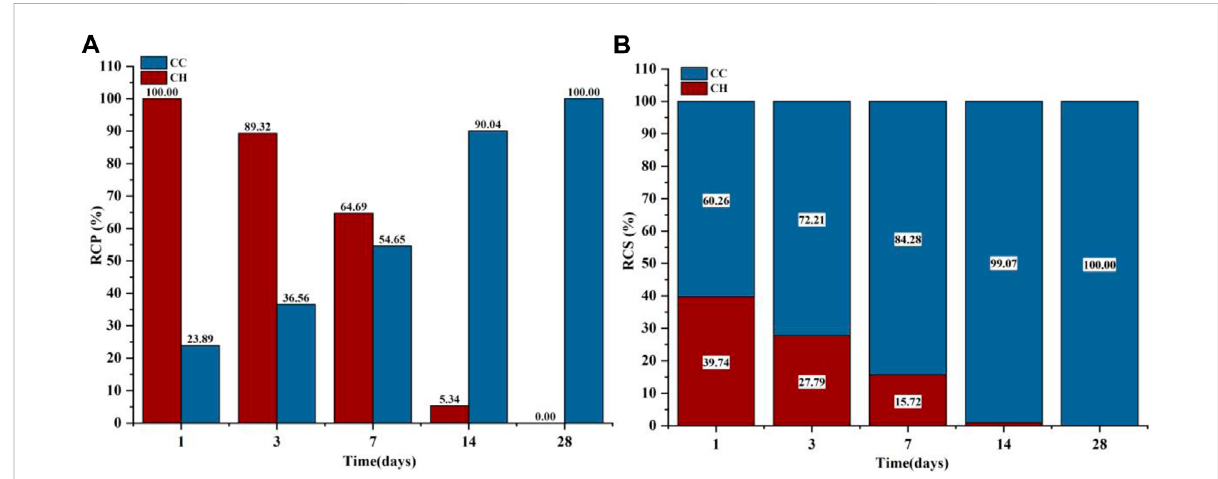
FIGURE 6 GA-1,3,7,14,28 Samples: (A) Carbonized crystalline product RCP; (B) Carbonized crystalline product